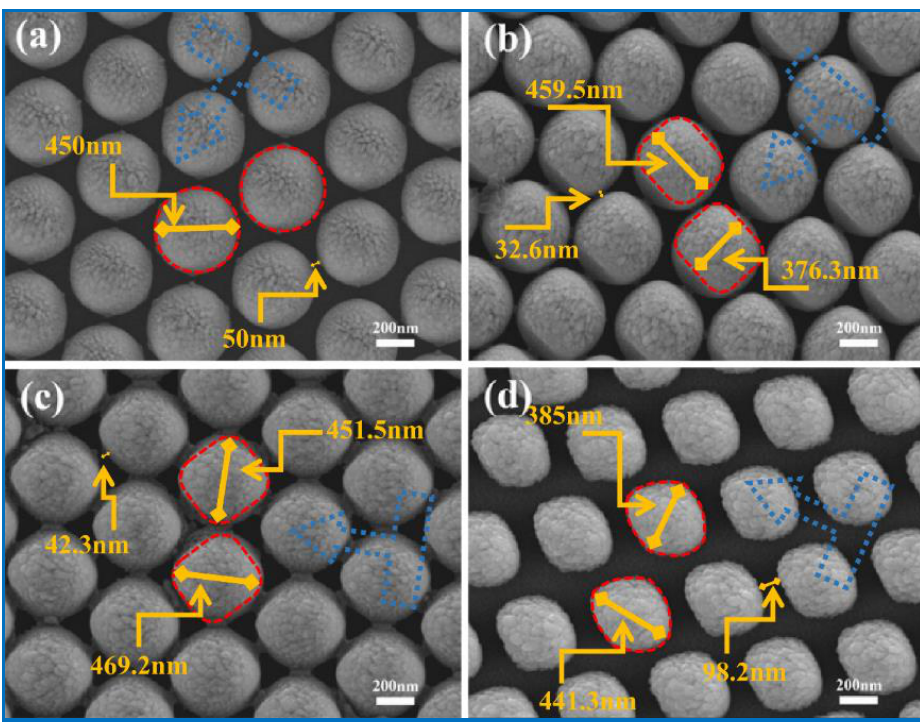
Figure 2. SEM images of nanocaps deposited on PS array after being etched for different times and with different OAD angles ( a ) 3 min, 30 degrees; ( b ) 3 min, 50 degrees; ( c ) 3 min, 50 degrees; and ( d ) 5 min, 70 degrees.